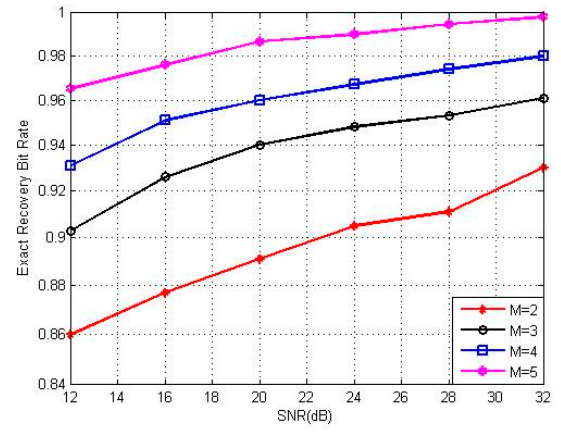
Figure 5. Recovery performance with transmission node (N).